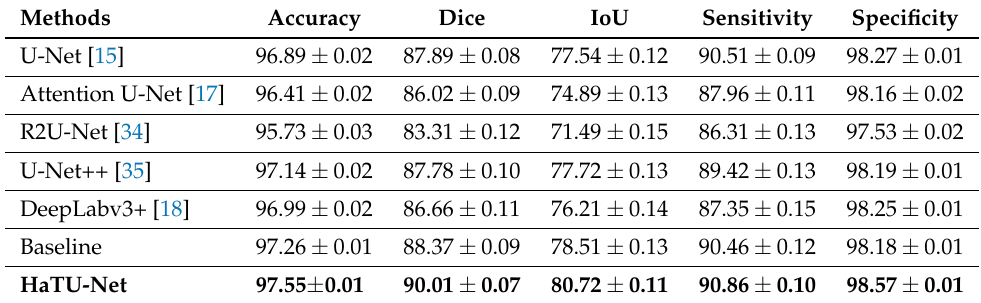
Table 3. Comparing of the proposed model for ovary segmentation with five state-of-the-art segmen- tation methods. Statistically significant results are highlighted in